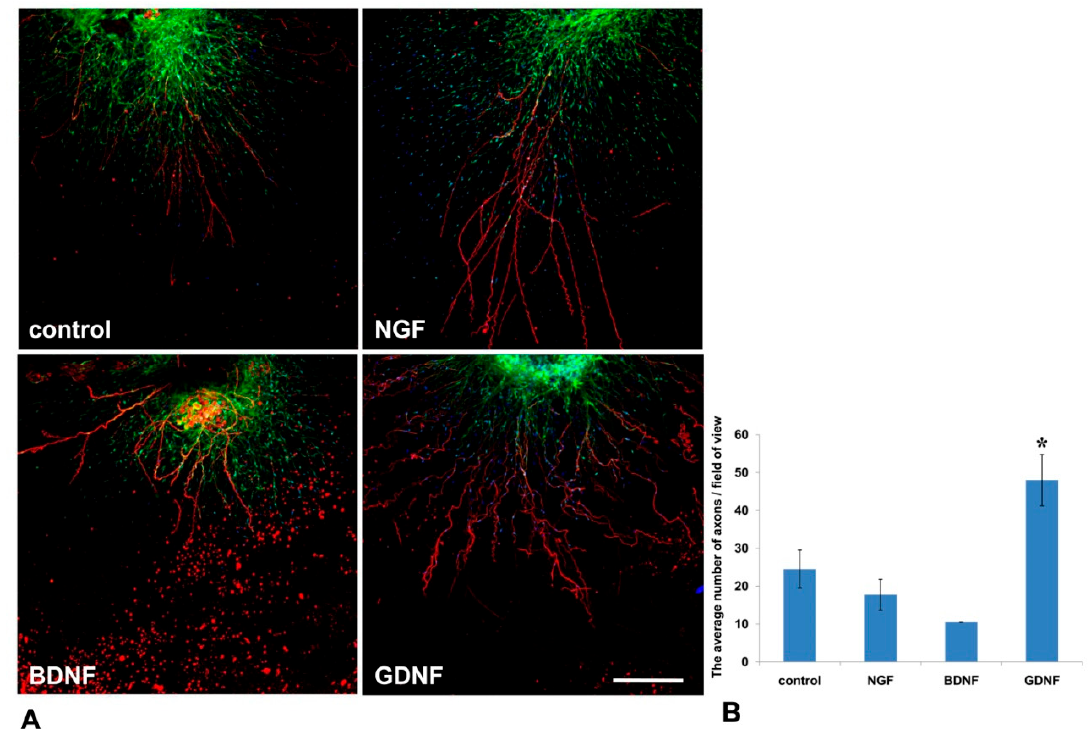
Figure 5. GDNF stimulated axon outgrowth from DRGs into Matrigel in the 3D explant model. NFG, GDNF, or BDNF was added to the culture media. ( A ) Immunofluorescent staining of mouse DRG in a Matrigel drop. Axons were visualized with antibody staining against NF200 (red fluorescence), nuclei counterstained with DAPI, and Nestin-positive cells (green fluorescence). Scale bar: 250 μ m. ( В ) A graph presenting the quantification of axon growth. Data are presented as mean ± standard deviation (SD). p < 0.05, n = 4. (SD). * p < 0.05, n =